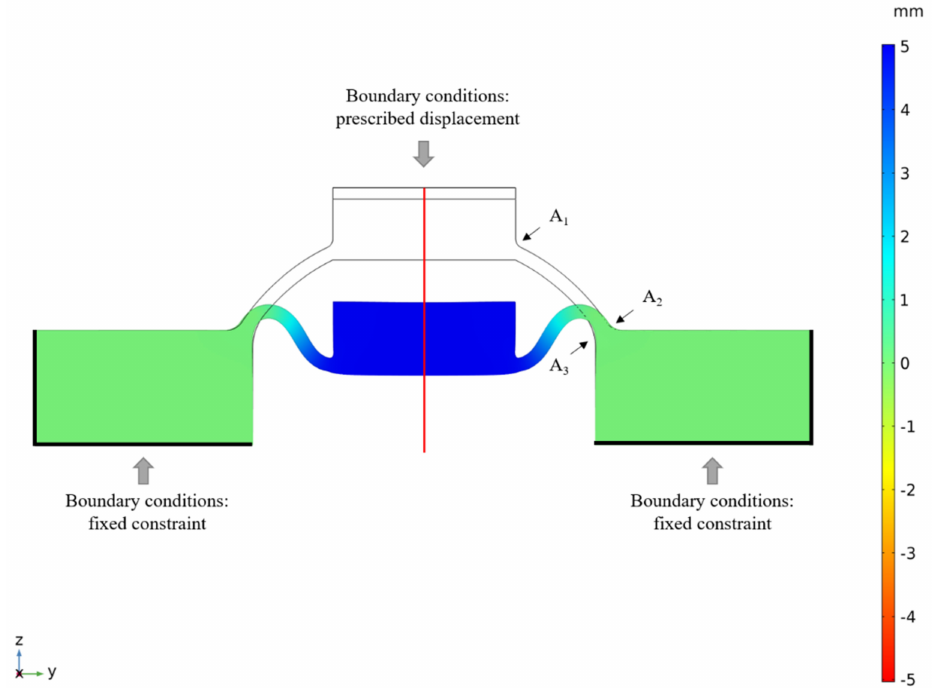
Figure 8. Two-dimensional (2D) FE model of the dome. Boundary conditions are explicitly reported as black solid lines. The non-colored image indicates the undeformed configuration, while the colored one shows the dome deformation through the colormap on the right-hand side. Note: due to radial symmetry, only the part of the dome which is located at positive y-coordinates is actually modeled.